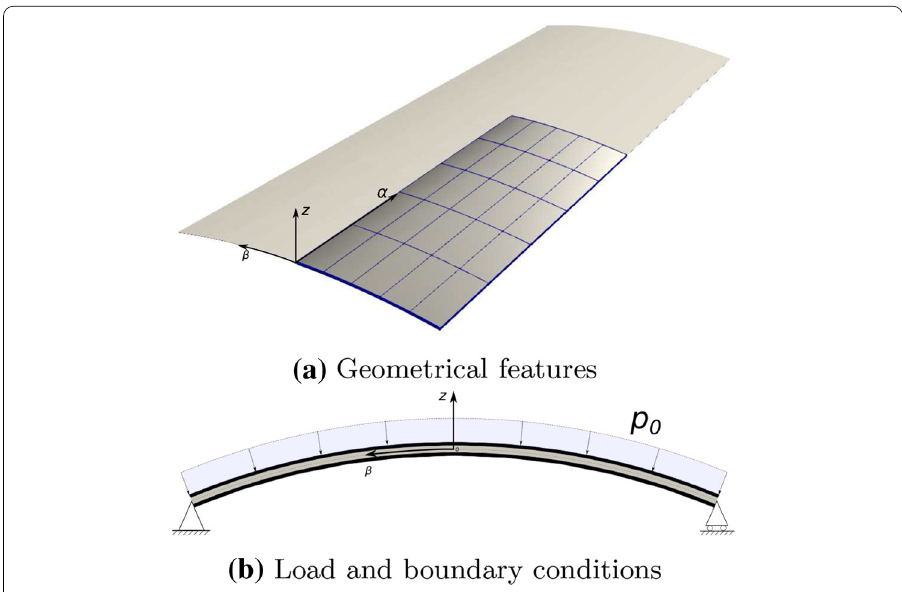
Fig. 12 Three-layered cylindrical panel under simple supports on two ends